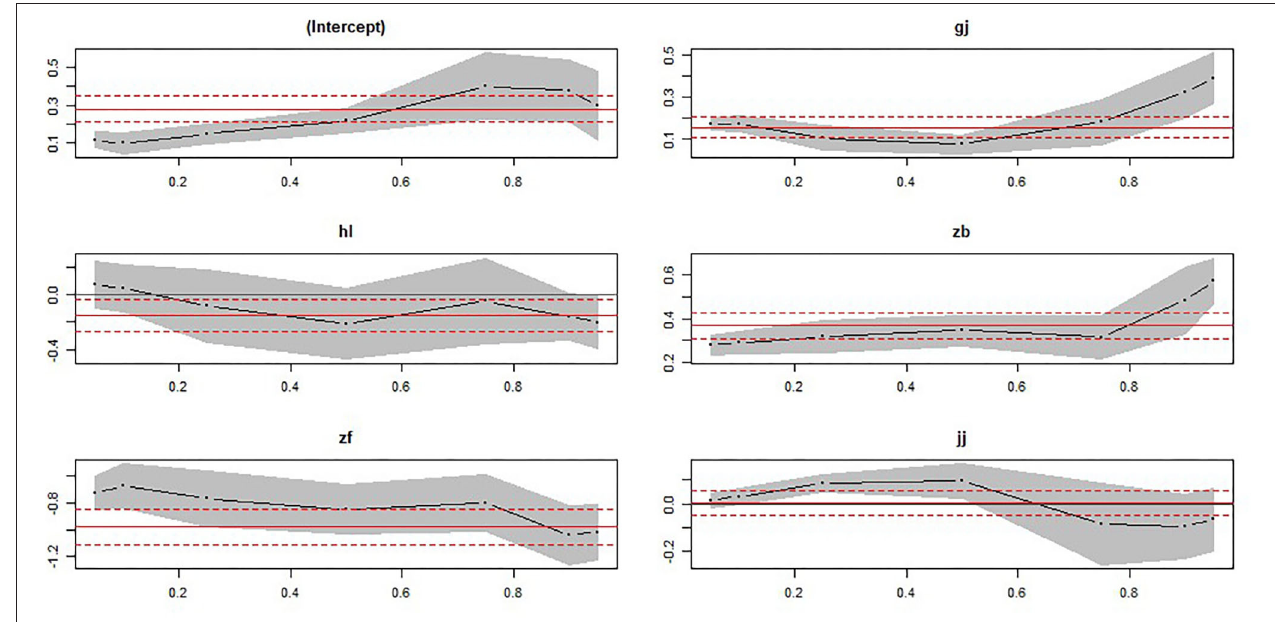
FIGURE 3 | Correlation coefficient change